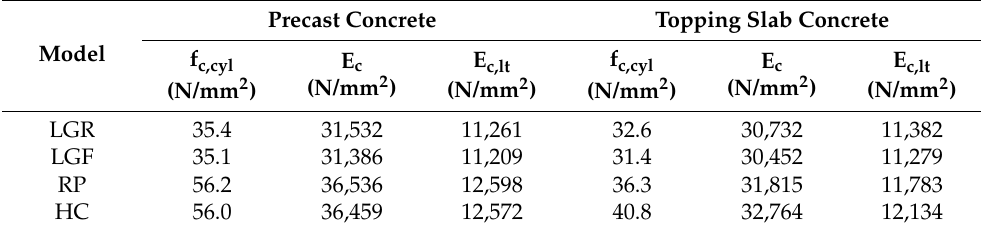
Table 2. Properties of concrete in the models made as specified in the standards [58–61].